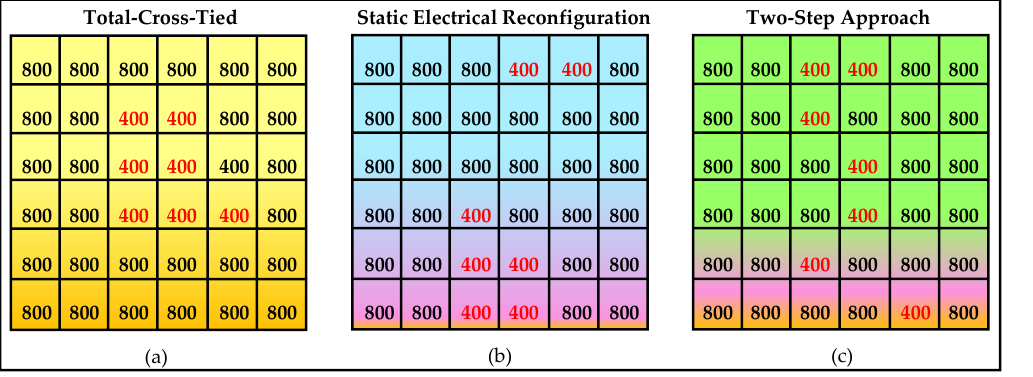
Figure 11. Irradiance received by the 6 × 6 PV array during partial shading S3 for ( a ) conventional, hybrid and TCT, ( b ) static electrical reconfiguration (shade dispersion), and ( c ) the two-step approach (shade dispersion). Table 3. Summarized mathematical estimation of the current, voltage and power values of the PV array under partial shading S3.